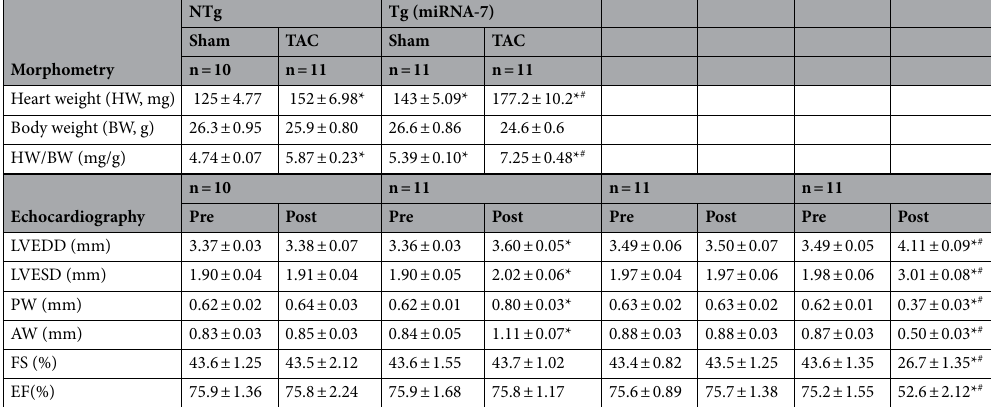
NTg Tg Morphometry